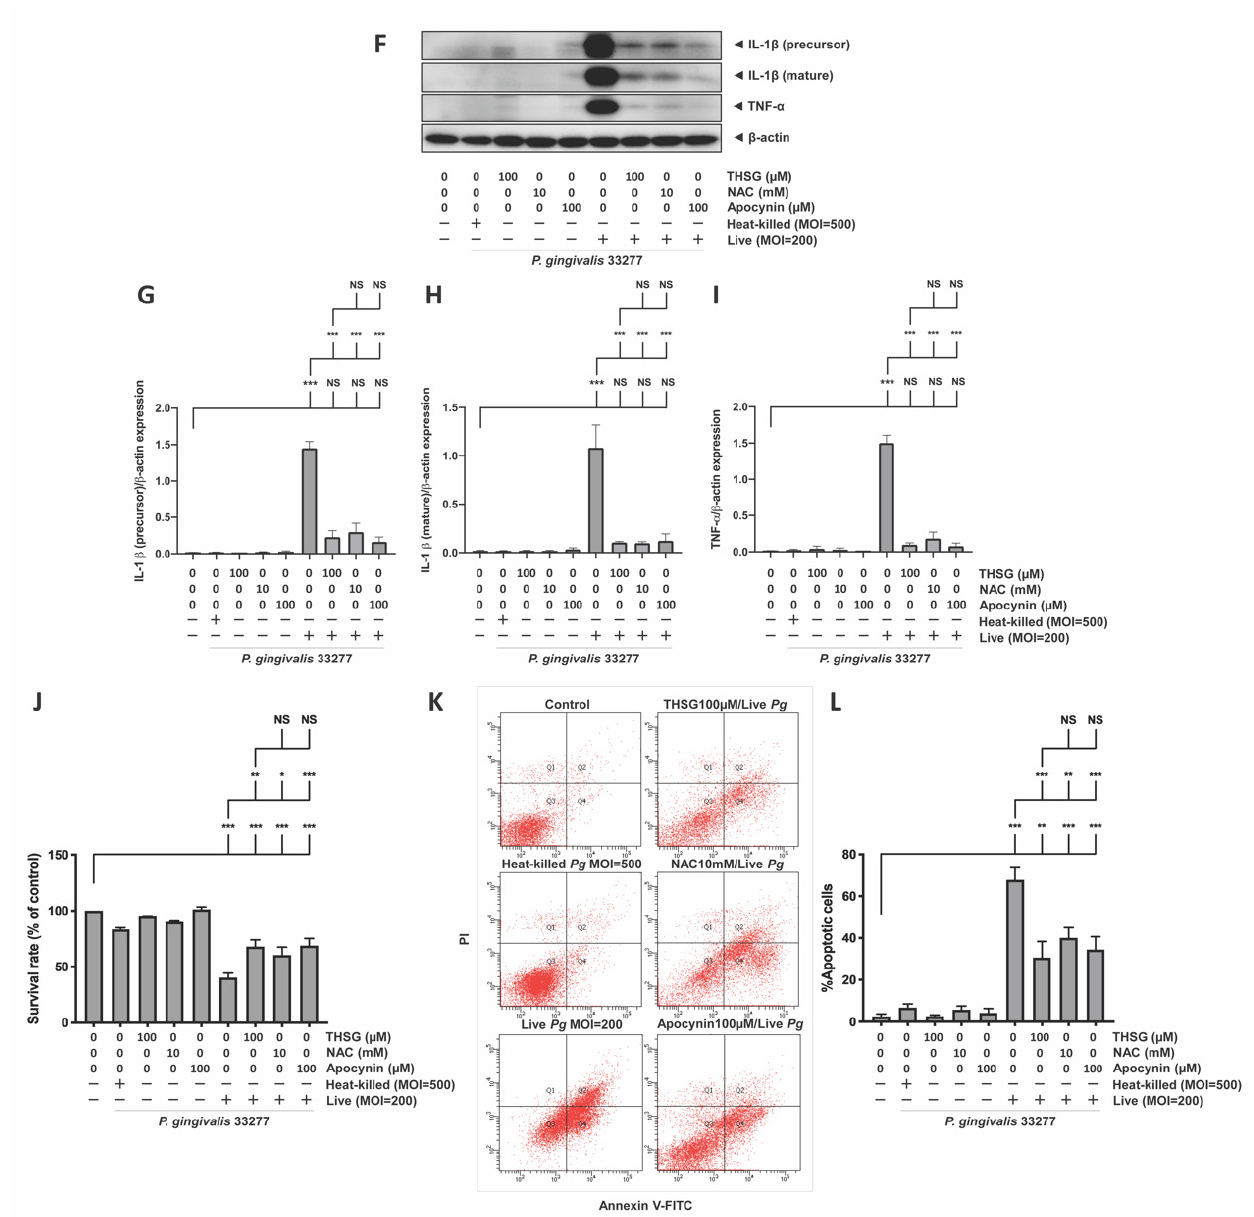
Figure 4. THSG treatment mitigates the toxicological effect of ROS production and NF- κ B activation under P. gingivalis infection. bEnd.3 cells were treated with 100 µ M THSG, 10 mM NAC, or 100 µ M apocynin for 2 h before being challenged with P. gingivalis (MOI 200). ( A ) ROS production was elucidated by DCFH-DA (50 µ M) and was analyzed using a flow cytometer. The quantitative results of DCF fluorescence intensity (P2 populations) are shown in ( B ). The protein expressions of I κ B α and NF- κ B p65 protein were analyzed by Western blot ( C ). The quantitative results of I κ B α and NF- κ B p65 are shown in ( D , E ). The protein expressions of IL-1 β and TNF- α were detected by Western blot ( F ). The quantitative results of IL-1 β and TNF- α are shown in ( G – I ). ( J ) The cell viability was examined by MTT assay in the percentage of control. ( K ) Cell apoptosis was determined by Annexin V FITC/PI staining and analyzed with a flow cytometer. The quantitative percentage of apoptotic cells are shown in ( L ). Data in bar graphs are expressed as mean values ± SEM (n = 4). Significant difference of the control, THSG 0 µ M, THSG 100 µ M group are presented as *, p < 0.05; **, p < 0.01; ***, and p < 0.001. NS: not